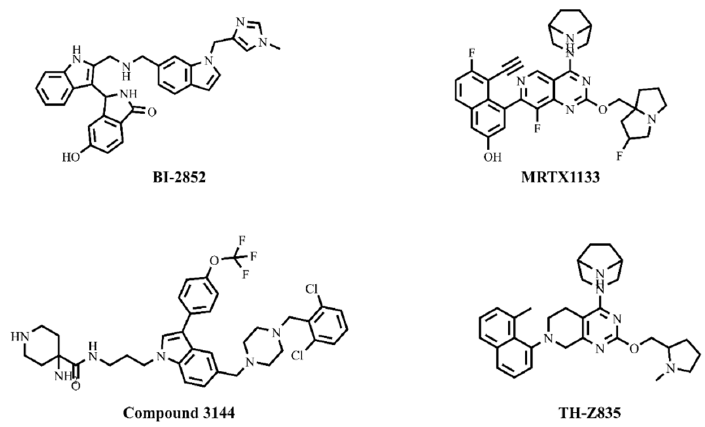
Figure 1. 2D structures of KRAS G12D inhibitors.